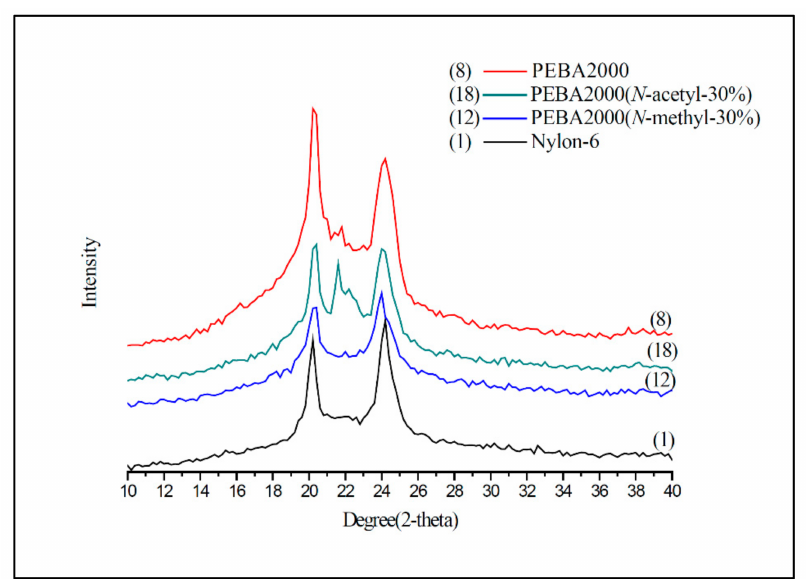
Figure 7. XRD spectra of Nylon-6, PEBA 2000, PEBA 2000( N -methyl-30%), and PEBA 2000( N